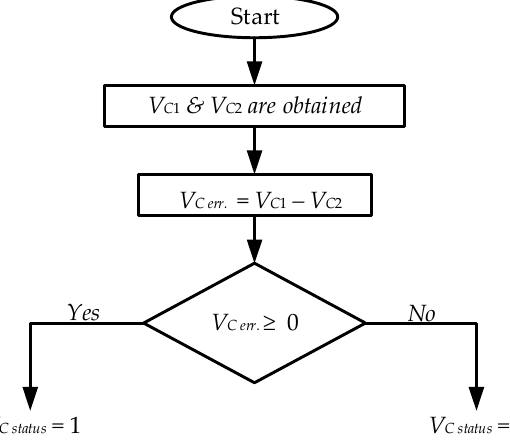
Figure 6. Three-level NPC inverter balancing control.